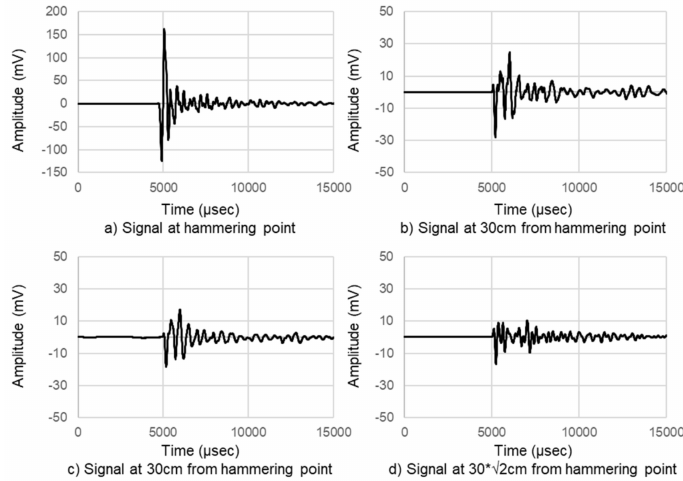
Figure 18. Principle of PIT (Pile Integrity Test).